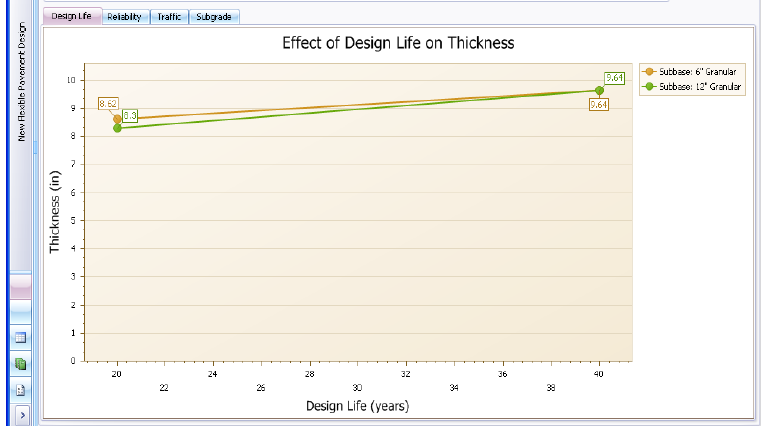
Figure 8. Screenshots of sensitivity analysis of design life on asphalt pavement thickness.